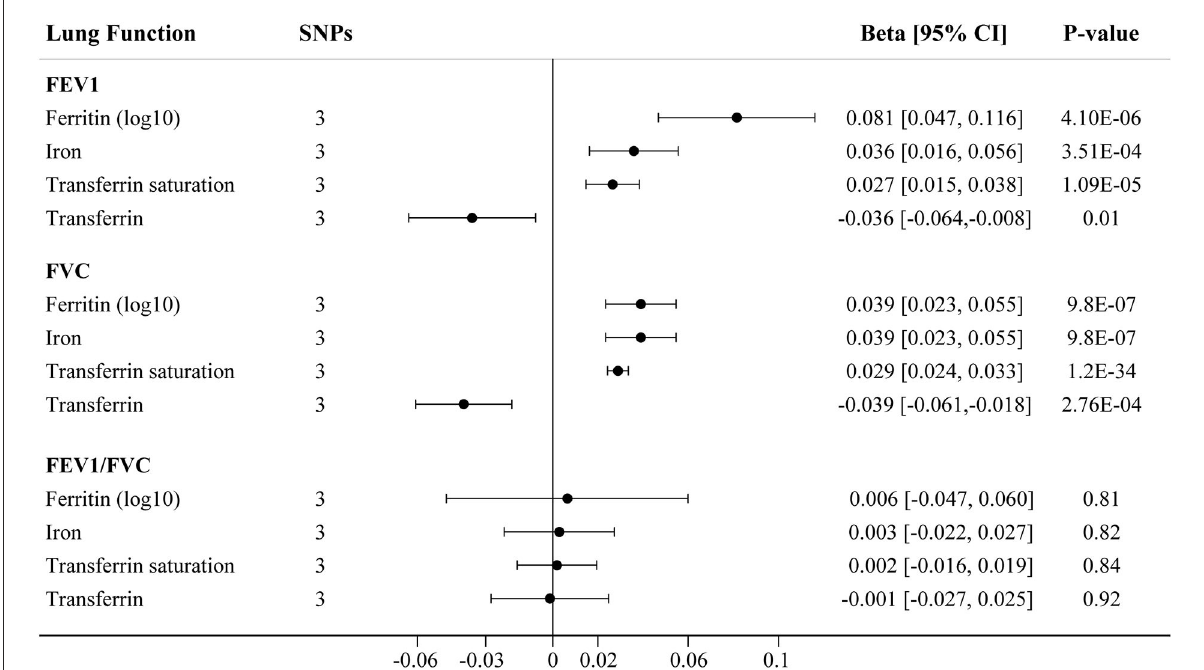
FIGURE2 The IVW MR estimates for relationship between iron status and lung function using conservative instrumental variables associated with all four iron biomarkers. The causal effects of iron status on levels of FEV1, FVC, and FEV1/FVC ratio are estimated. Results are reported as beta with corresponding 95% CI per SD unit increase in each iron marker. IVW, inverse variance weighted; MR, Mendelian randomization; FEV1, forced expiratory volume in 1s; FVC, forced vital